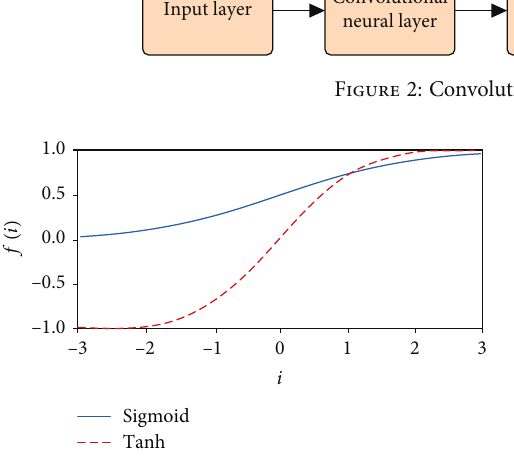
Figure 3: Saturated nonlinear activation function.